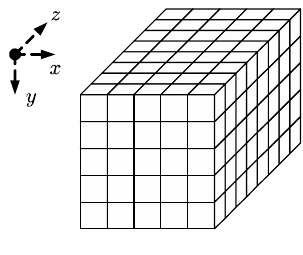
Figure 2: The Keccak- f